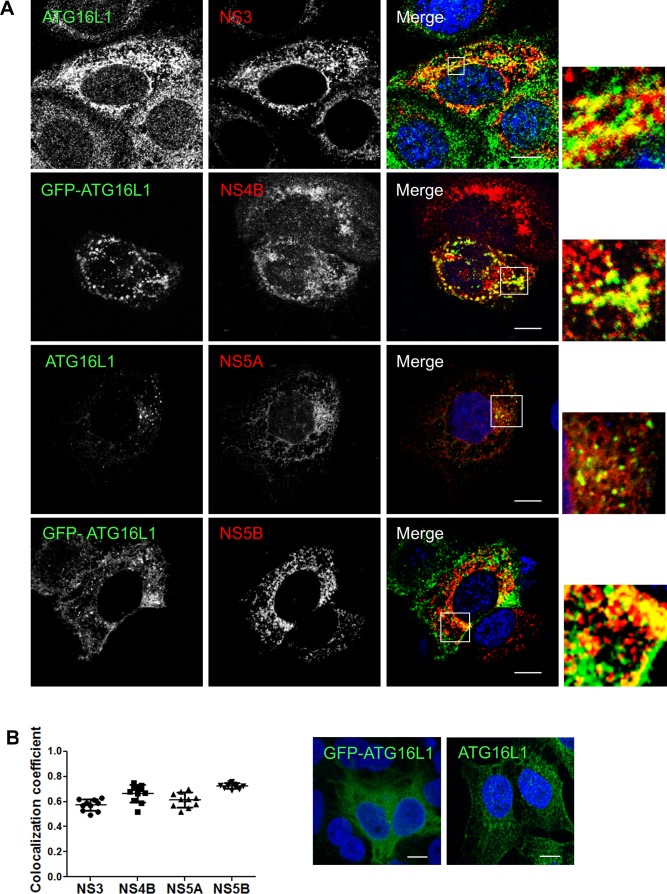
HCV nonstructural proteins colocalize with ATG16L1 in Huh7 cells.A. Huh7 cells infected with JFH1 at more than 90% and then transfected with pGFP-ATG16L1 or immunostained for endogenous ATG16L1 using a rabbit specific antibody. Confocal microscopy images displaying subcellular localization of GFP-ATG16L1 or endogenous ATG16L1 and viral NS3, NS4B, NS5A, and NS5B are shown. Scale bar, 10μm. B. The values of overlapping fluorescence signal of ATG16L1 and GFP-ATG16L1 with HCV nonstructural proteins were calculated using Manders’ colocalization coefficient (n = 5 cells, 10 arbitrary positions). C. Uninfected Huh7 cells transfected with pGFP-ATG16L1 (left) or immunostained for endogenous ATG16L1 (right) are depicted. ATG16L1 is shown in green and the nucleus in blue (Dapi). Scale bar, 10μm.